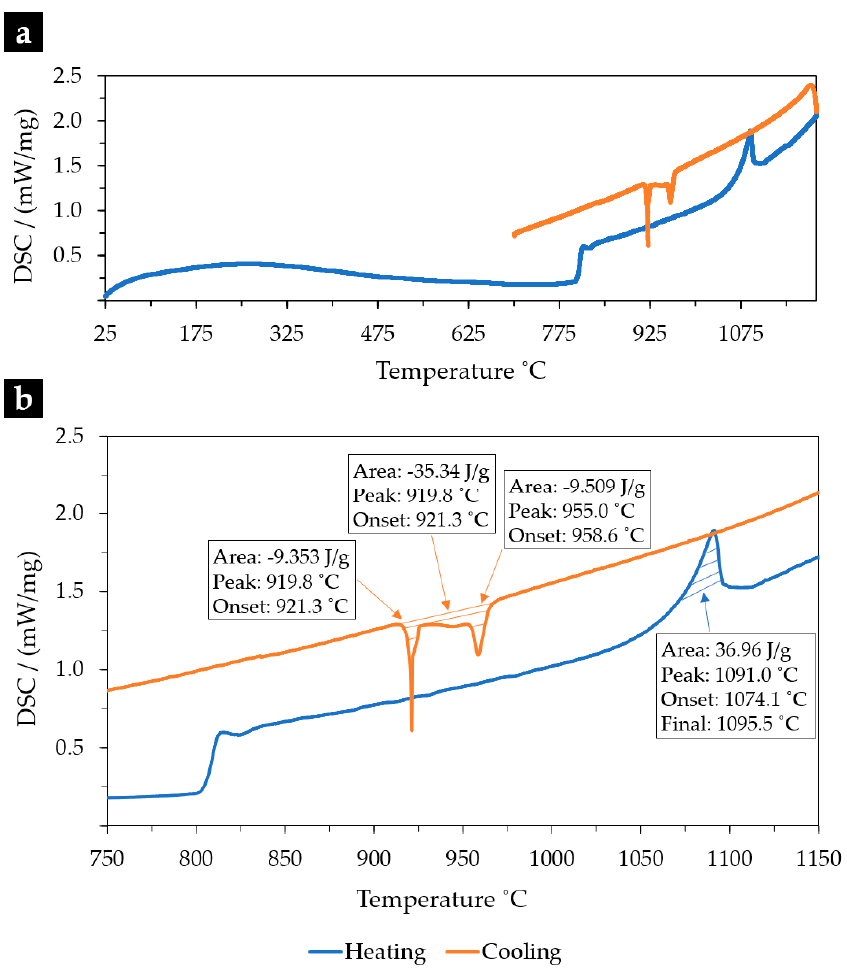
Figure 1. ( a ) DSC heating and cooling curves with rates of 10 ◦ C/min of the NiSi3B2 alloy; ( b ) zoomed in, showing the main phase transformations.